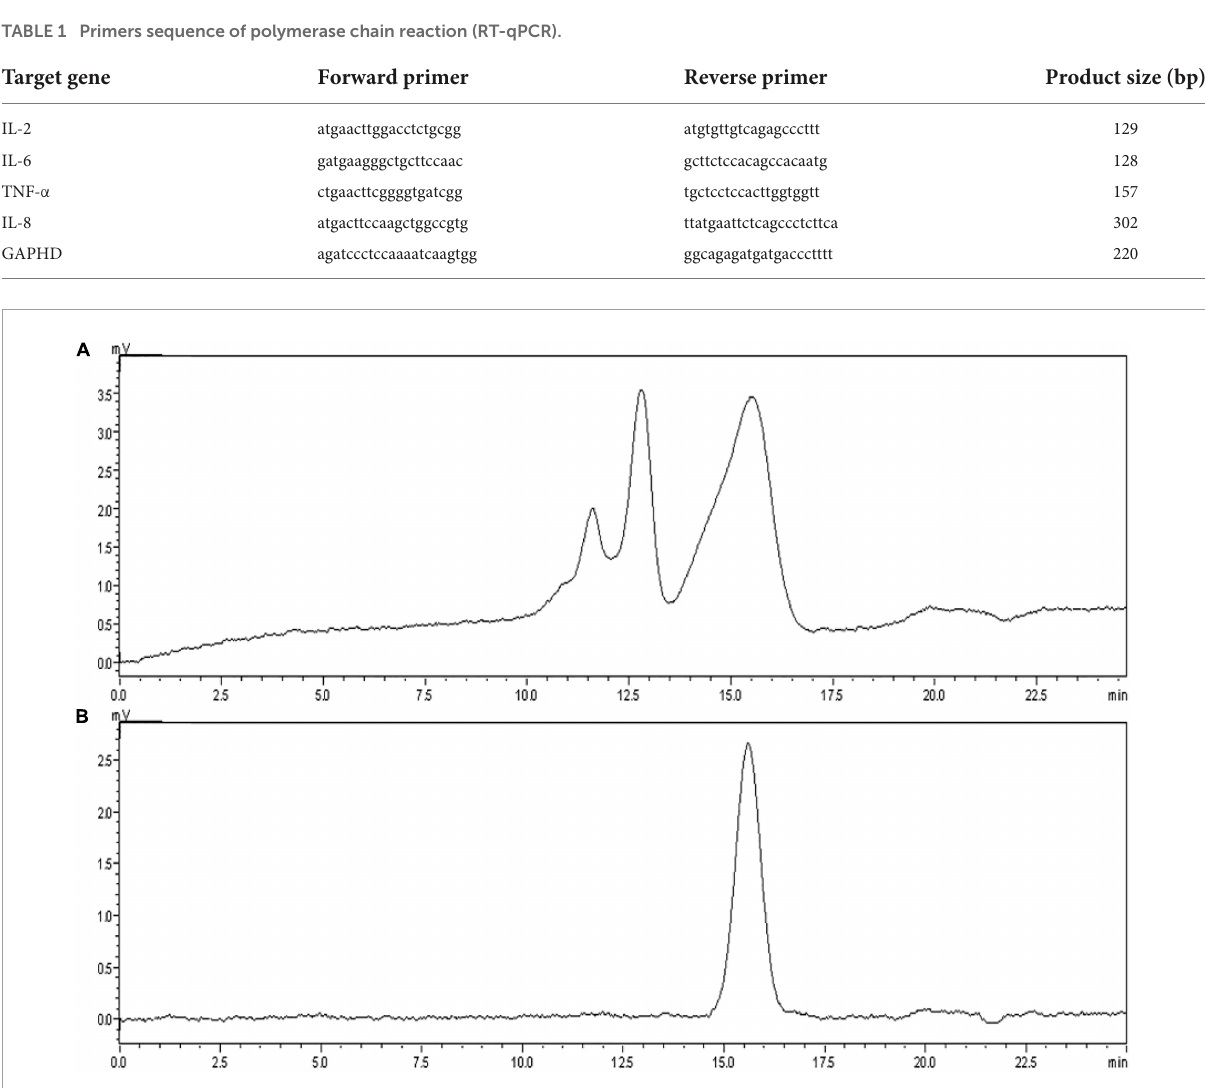
FIGURE1 Weight average distribution of (A) CCP1 (crude polysaccharides eluted with 0.3 M NaCl) and (B) CCP2 (purified polysaccharides extracted from C. cornucopioides